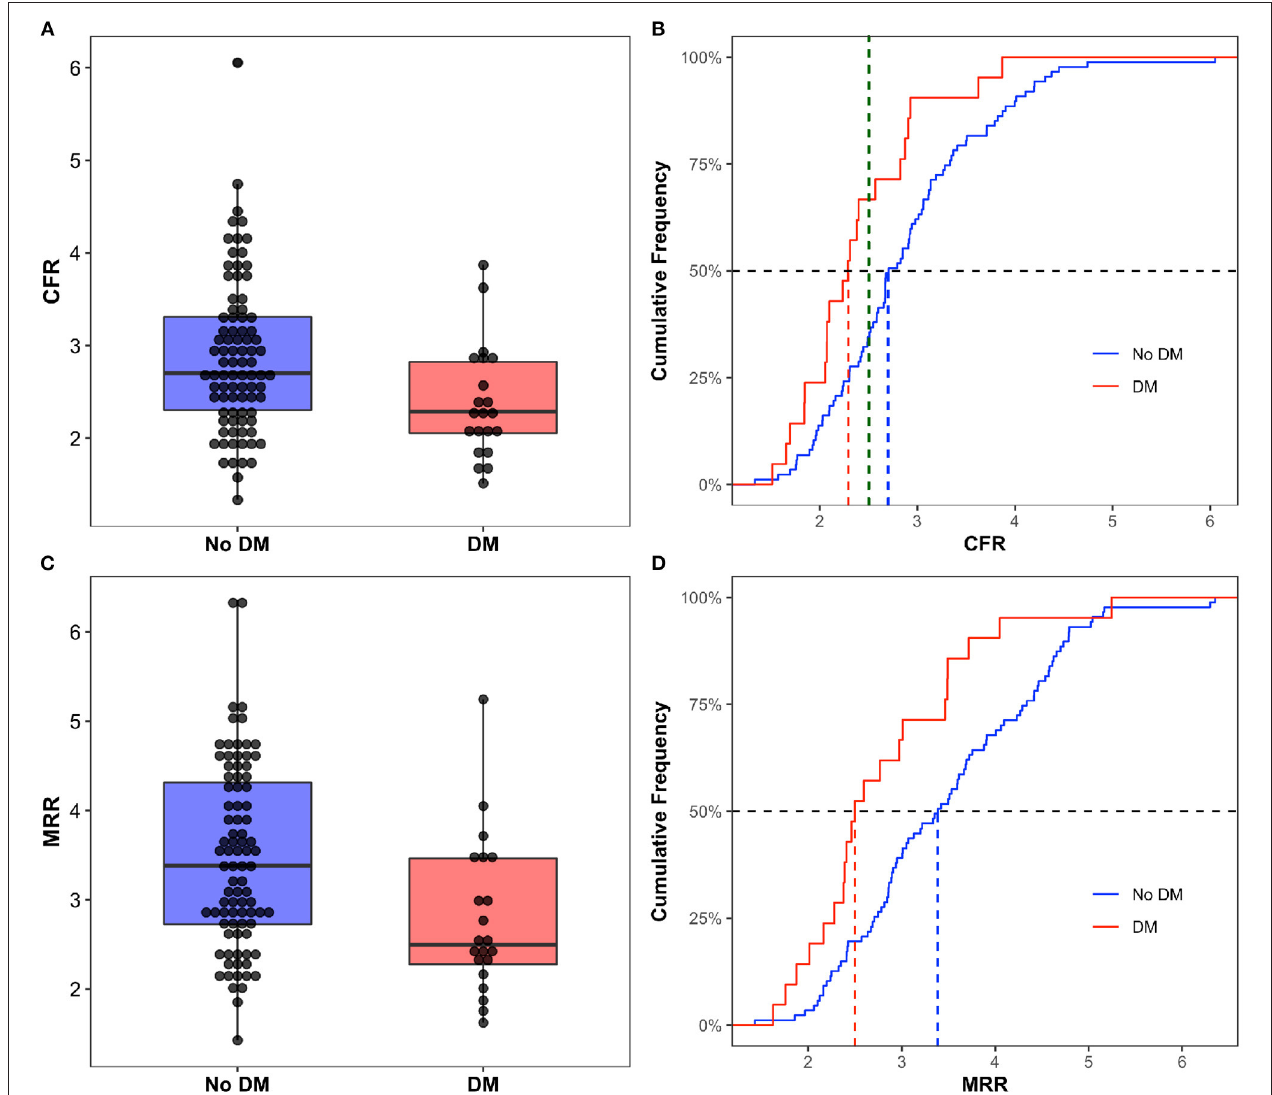
FIGURE 2 | Box Plot and Cumulative Frequency of CFR (A,B) and MRR (C,D) in diabetic and non-diabetic patients. In the (B) the dashed green line corresponds to a CFR = 2.5. DM, Diabetes Mellitus; CFR, Coronary Flow Reserve; MRR, Microvascular resistance Reserve.